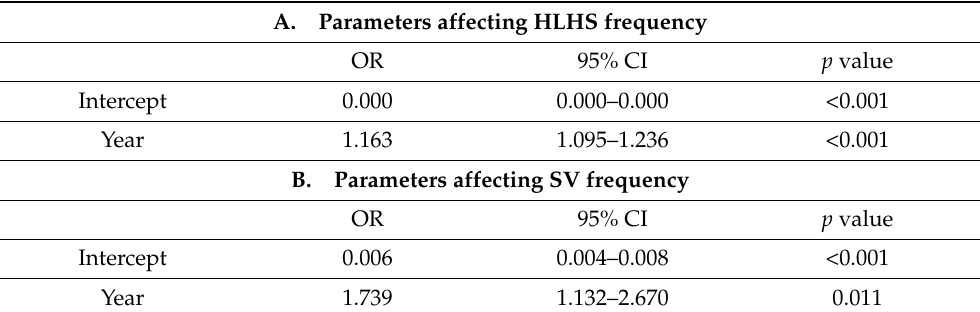
Table 2. The logistic regression model (a forward stepwise model) testing the parameter affecting HLHS (A) and SV (B)